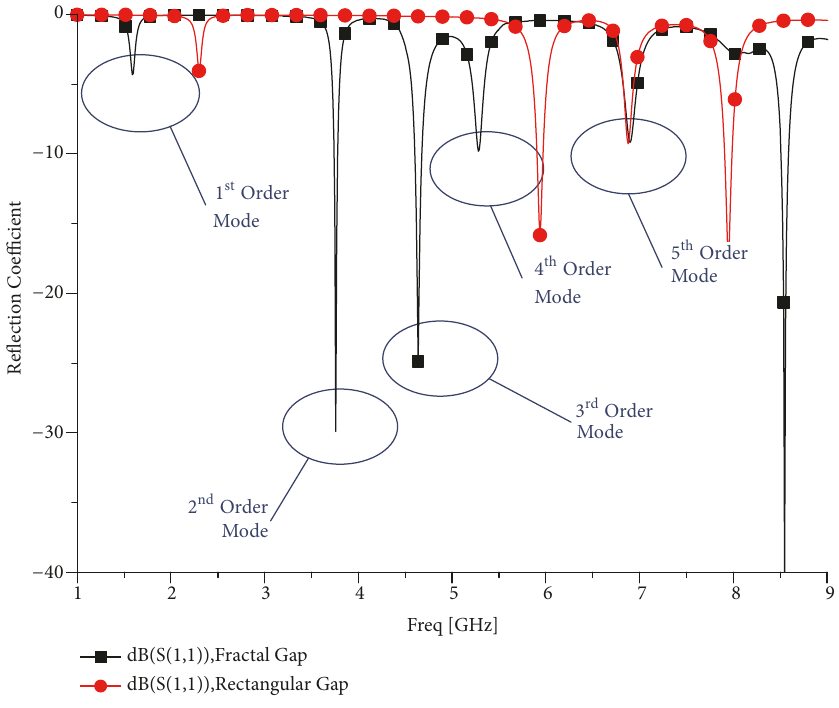
Figure 2: Whole mode resonator return loss characteristic.